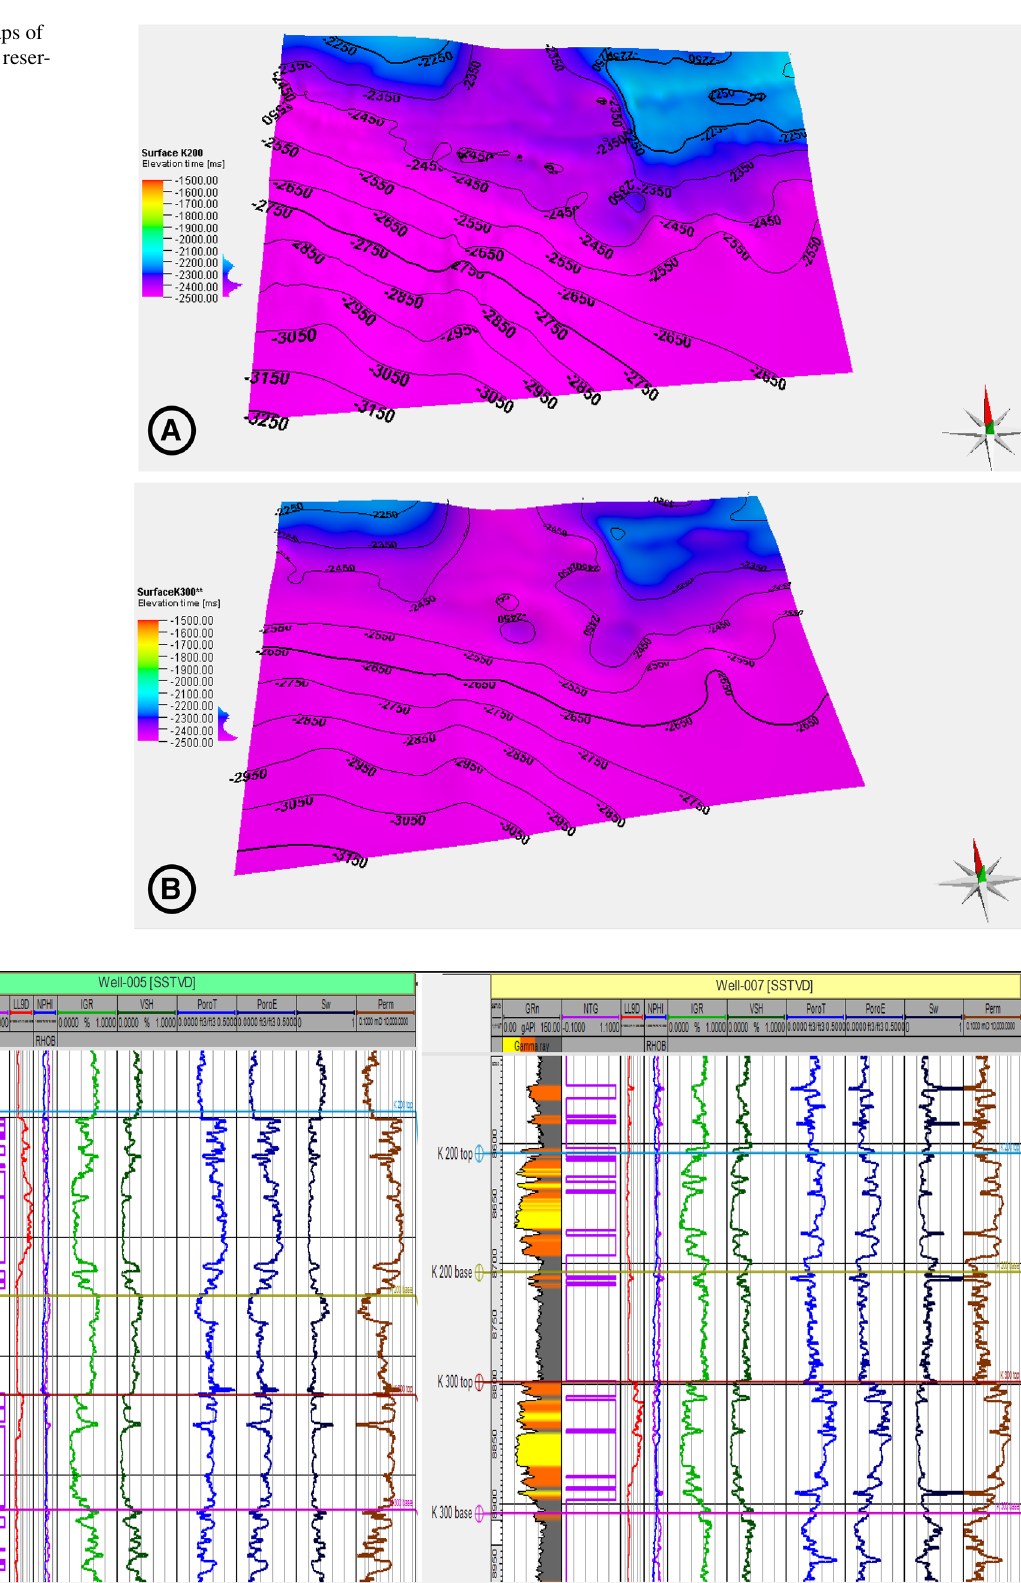
Fig. 7 Time surface maps of